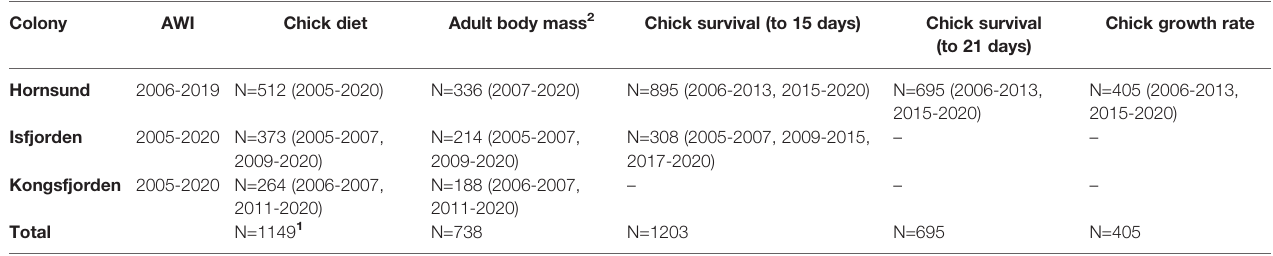
TABLE 1 | Sample sizes of, and time periods covered by, the datasets on the Atlantic Water Index (AWI), proportion of Atlantic prey in little auk chick diet, adult body mass, chick survival and chick growth rate for three western Svalbard fjords (Hornsund, Isfjorden and Kongsfjorden). Colony AWI Chick